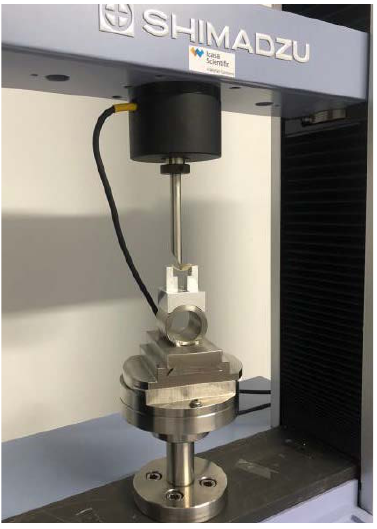
Figure 3. Bending of specimen